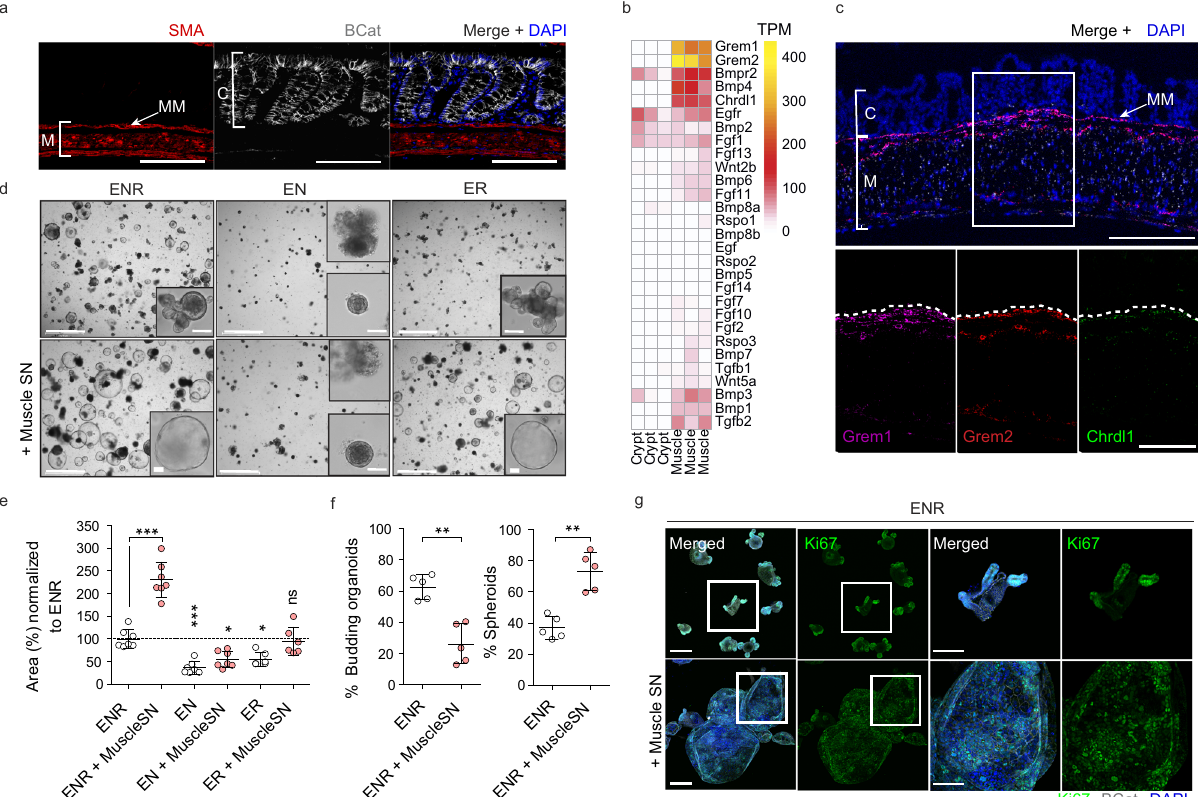
Fig. 1 Intestinal Smooth muscle expresses BMP antagonists that control epithelial behavior. a Representative confocal maximum intensity projection of a transverse colon cut showing speci fi c staining for muscle (M), SMA (Red), and crypts (C), β Catenin ( β cat, Gray). Clear distinction among muscularis mucosa (MM) close to the crypts and the muscularis propria (circular and longitudinal smooth muscle) can be observed. Scale bar 100 µ m. n = 4 mice. b Heatmap depicting gene expression levels in TPM (Transcripts per million) in crypts vs muscle intestinal samples. n = 3 biological replicates. c Representative confocal maximum intensity projections of fl uorescence-coupled RNAscope showing BMP antagonists Grem1 in magenta, Grem2 in red, and Chrdl1 in green, expressed in smooth muscle cells. Scale bar 100 µ m; 50 µ m in the magni fi ed image. n = 2 mice. d Representative bright- fi eld pictures showing SI organoids morphological changes when exposed to muscle-derived factors (Day4). Control media ENR (EGF, NOGGIN, RSPO1), EN (no RSPO1) or ER (no NOGGIN) were used to assess SI organoids reliance on external growth factors. Scale 1250 µ m; 100 µ m in magni fi ed image. e Graph shows SI organoids area in response to different media. Depicted average values normalized to ENR condition. n = 6 (for ER and ER + MuscleSN) to 7 (the rest) independently performed experiments. Each dot corresponds to the average of 2 – 3 wells/experiment. f Graphs represent the percentage of budding organoids or spheroids in response to ENR or ENR + muscle supernatant (Muscle-SN). n = 5 independently performed experiments with 2 – 3 wells/ experiment. g Representative maximum projection confocal images showing proliferative active cells (Ki67) in green and cell shape ( β cat, gray)